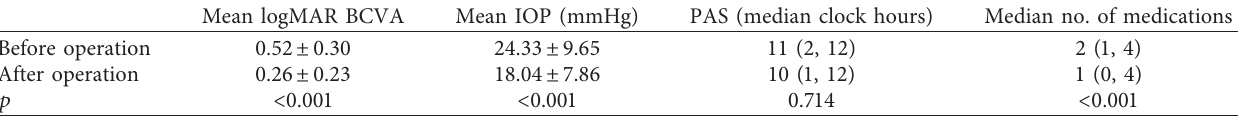
Table 2: Comparisons between preoperative and postoperative logMAR BCVA, IOP, PAS, and number of medications. Mean logMAR BCVA